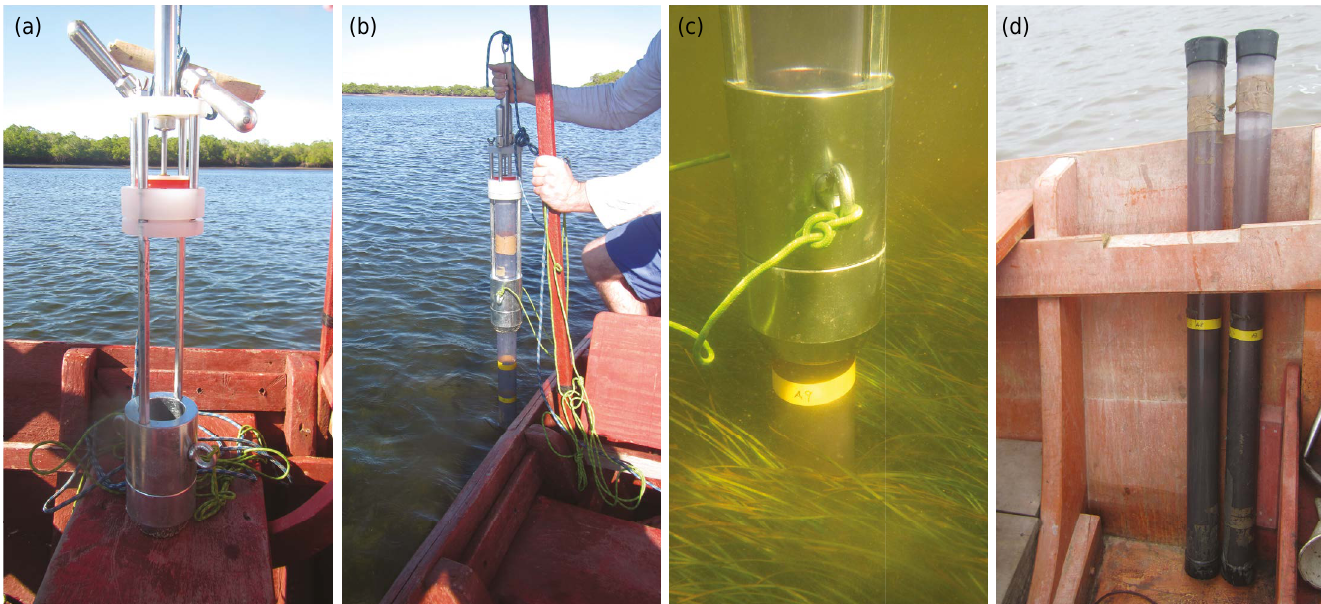
Figure 2. Subaqueous soil sampling procedure. Overall view of the soil sampler used (a) and onboard launch (b). Close view of the remote hammering system (c) and collected soil samples